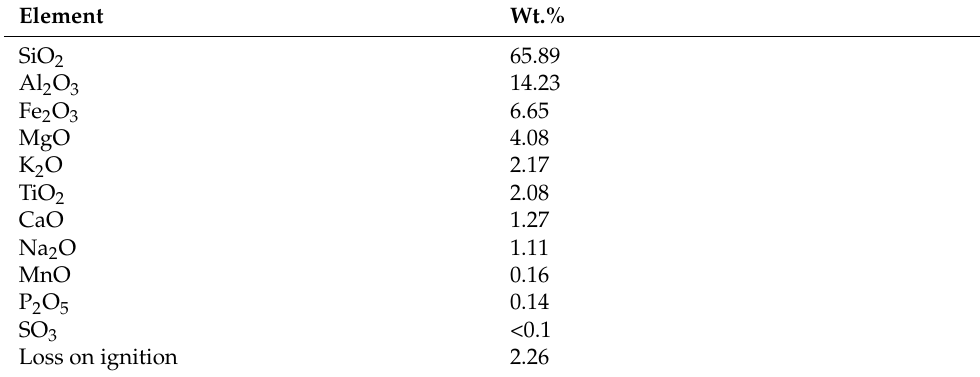
Table 5. Composition of soil 1 in weight obtained by EDS measures.